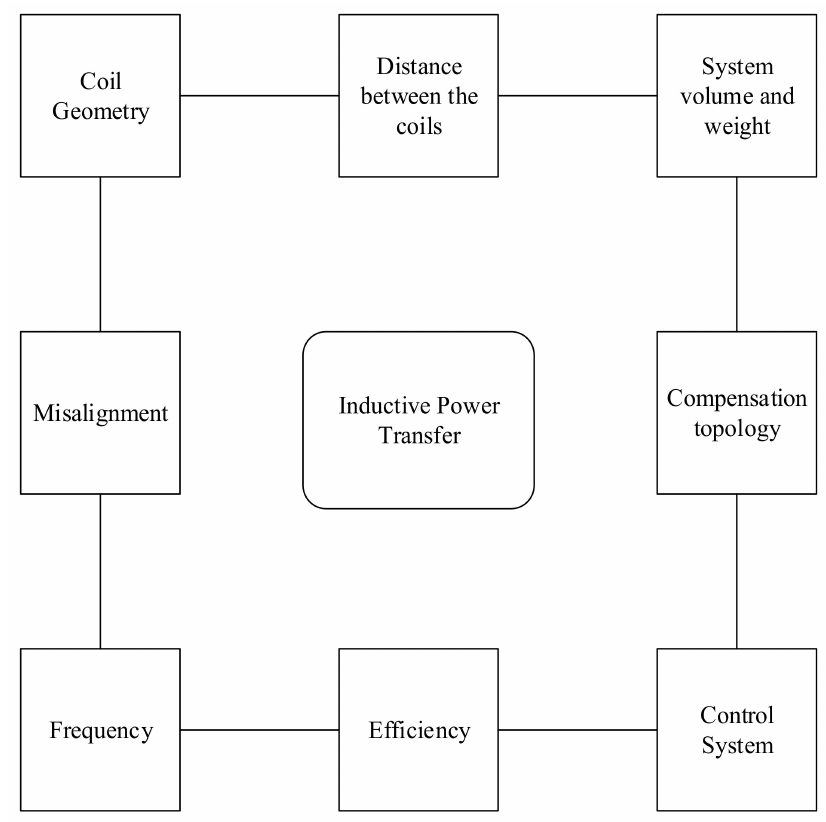
Figure 6. Overview of factors affecting an efficient IPT